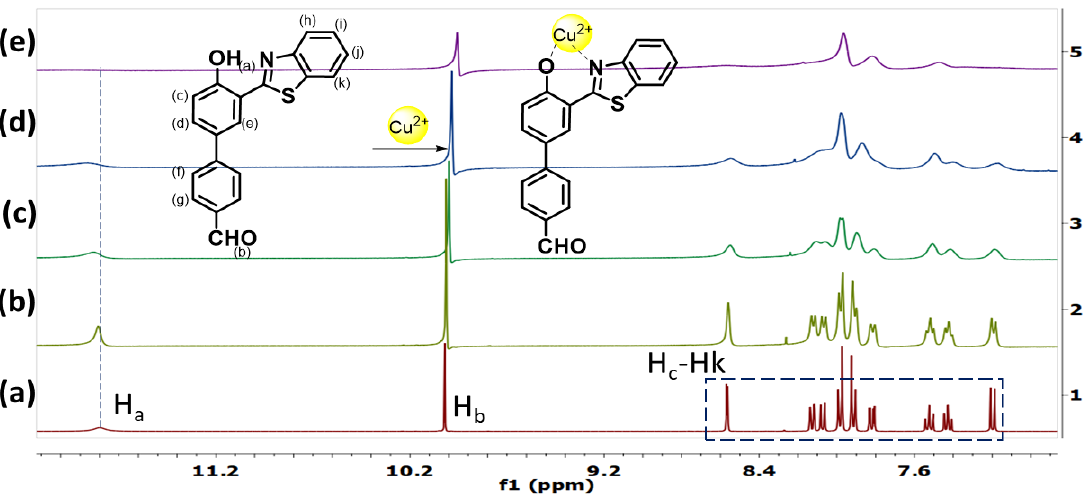
Figure 6. 1 H NMR spectra (partial) of HBT 2 (5 mM); ( a ) in the absence and presence of ( b ) 1; ( c ) 3; ( d ) 5 and ( e ) 10 equivalents of Cu 2+ ions recorded in DMSO( d 6 ).